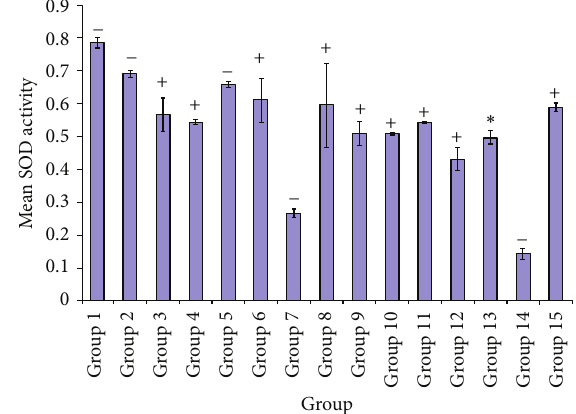
Figure 2: Comparative effects of some plants extracts in the superoxide dismutase